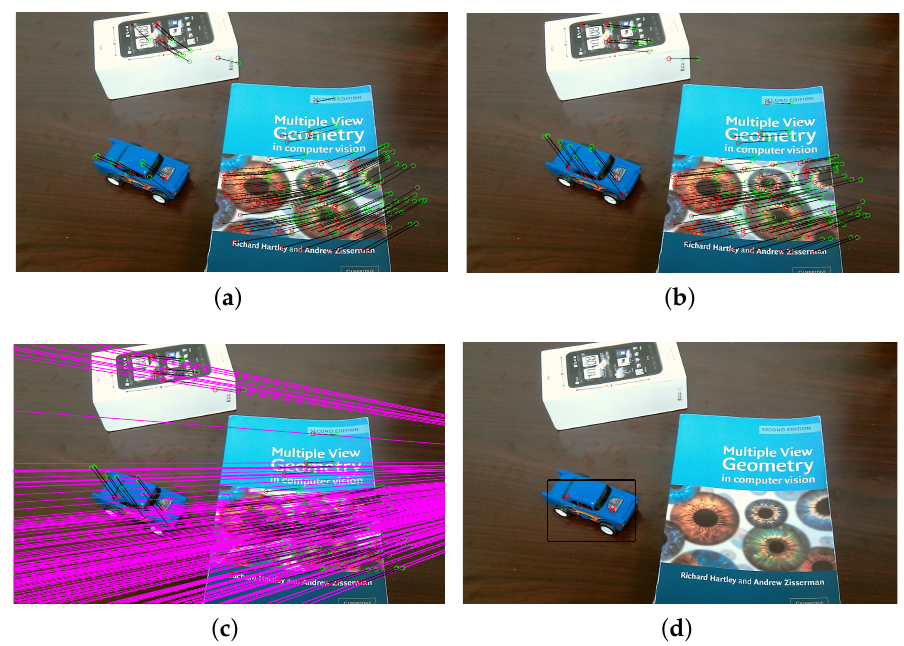
Figure 16. Experimental illustrations for homography recovery. ( a ) detected 2D feature points in first frame; ( b ) detected 2D feature points in second frame; ( c ) sorted feature matches; ( d ) detected toy car.